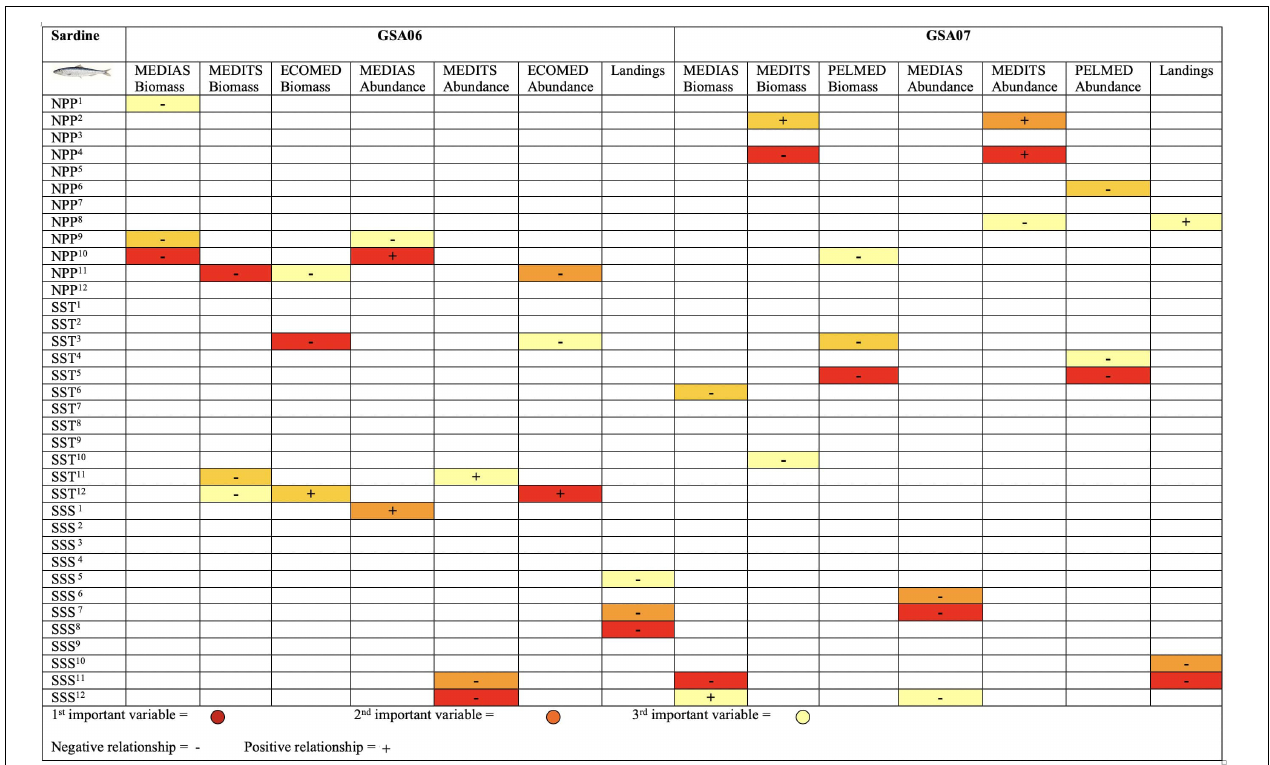
FIGURE 6 | Summary of the Random Forests results for European sardine ( Sardina pilchardus ) temporal index trends in the Geographical Sub-Area 06 and 07 from 2003 to 2016.This figure shows the ecological and statistical weight of each variable. (+) symbol indicates a positive relationship of the variable with the biomass, abundance or landings and (-) symbol indicates a negative relationship. The colors represent the range, from most to least important variable within the model (red the most relevant, orange medium relevancy and yellow the least relevant) based on the per cent increase in mean squared error- MSE).